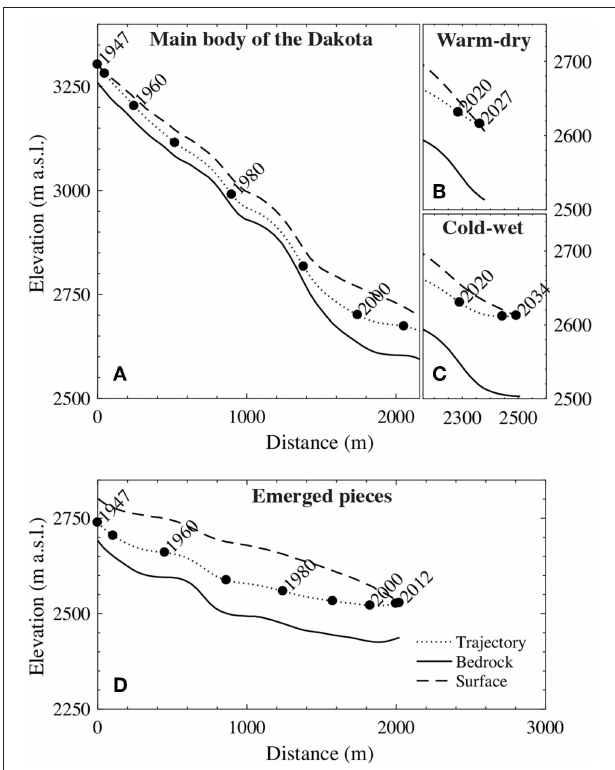
FIGURE 6 | Vertical section of the main body of the Dakota, of the surface with respect to time, and of the glacier and the bedrock (A) from 1947 to 2014, (B) using the warm-dry scenario from 2014 to 2027, and (C) using the cold-wet scenario from 2014 to 2034, where the x-axis shows the distance from the crash site. Image (D) shows the same for the emerged pieces from 1947 to 2012, where the x-axis indicates the distance from their initial position.